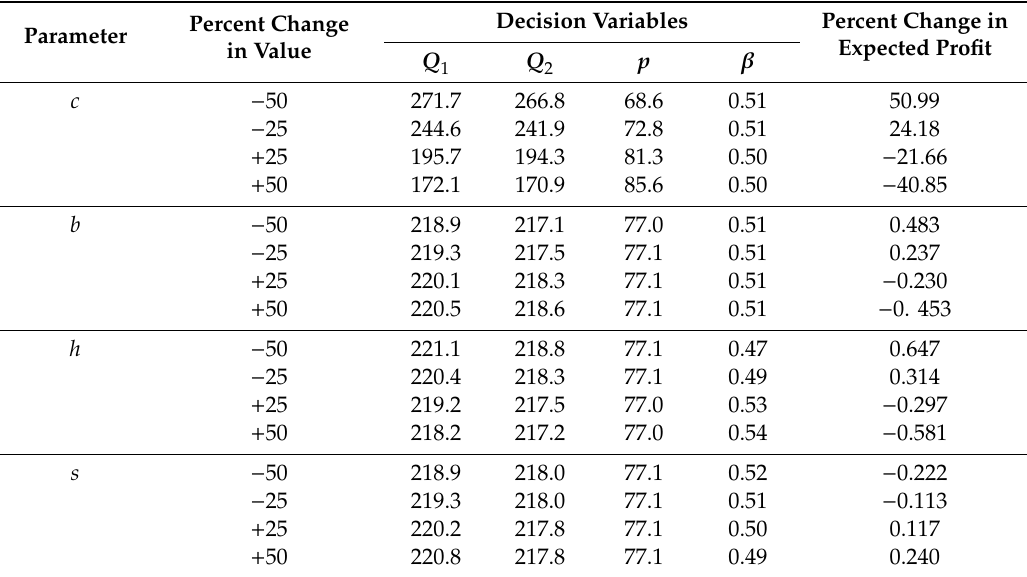
Table 2. Sensitivity analysis for the key operational